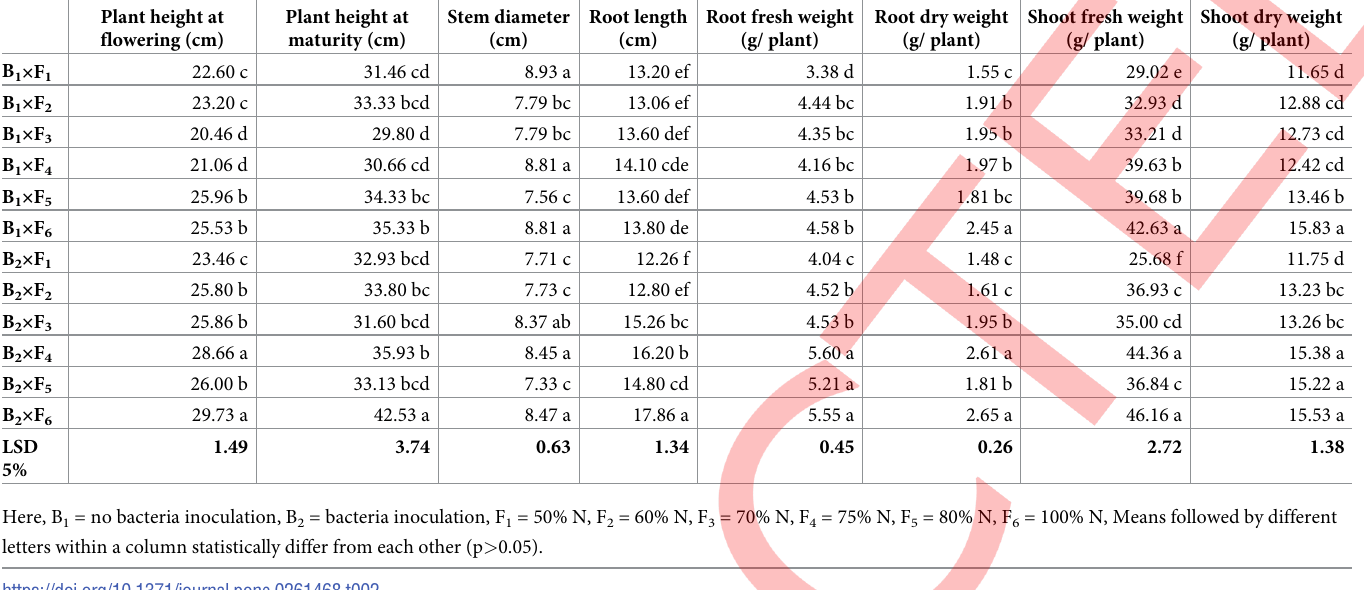
Table 2. The impact of different rhizobacteria inoculation on growth traits and biomass accumulation in roots and shoot of chili grown under different nitrogen doses. Plant height at flowering (cm)